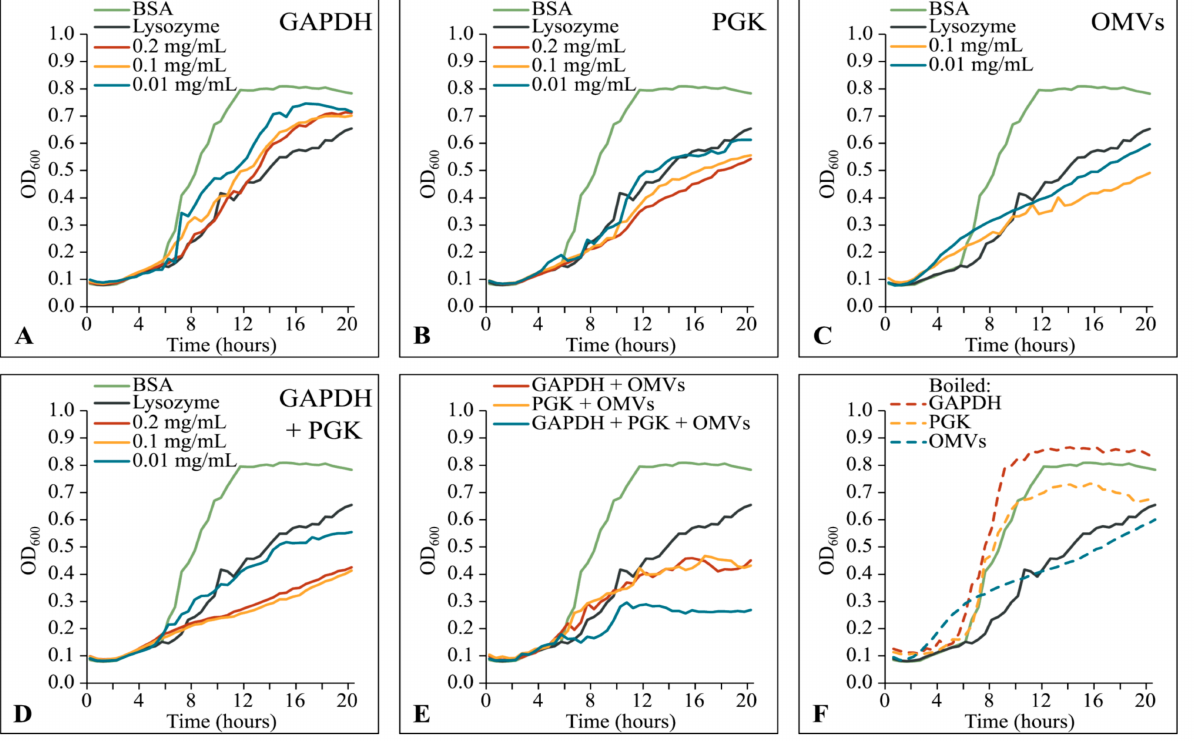
Figure 6. Growth curves of E. coli in the presence of GAPDH, PGK and/or OMVs. In graphs A-F BSA (bovine serum albumin) (0.1 mg/mL) and lysozyme (0.1 mg/mL) are shown in green and dark grey, respectively. Red, yellow and blue lines indicate 0.2, 0.1 and 0.01 mg/mL, respectively, of the added component in ( A – D ). ( A ) 6His-GAPDH. ( B ) 6His-PGK. ( C ) OMVs. ( D ) 6His-GAPDH and 6His-PGK. ( E ) OMV mixtures with enzymes (each component at 0.1 mg/mL). ( F ) 0.1 mg/mL of boiled 6His-GAPDH, 6His-PGK or OMVs. Lines represent the mean of three